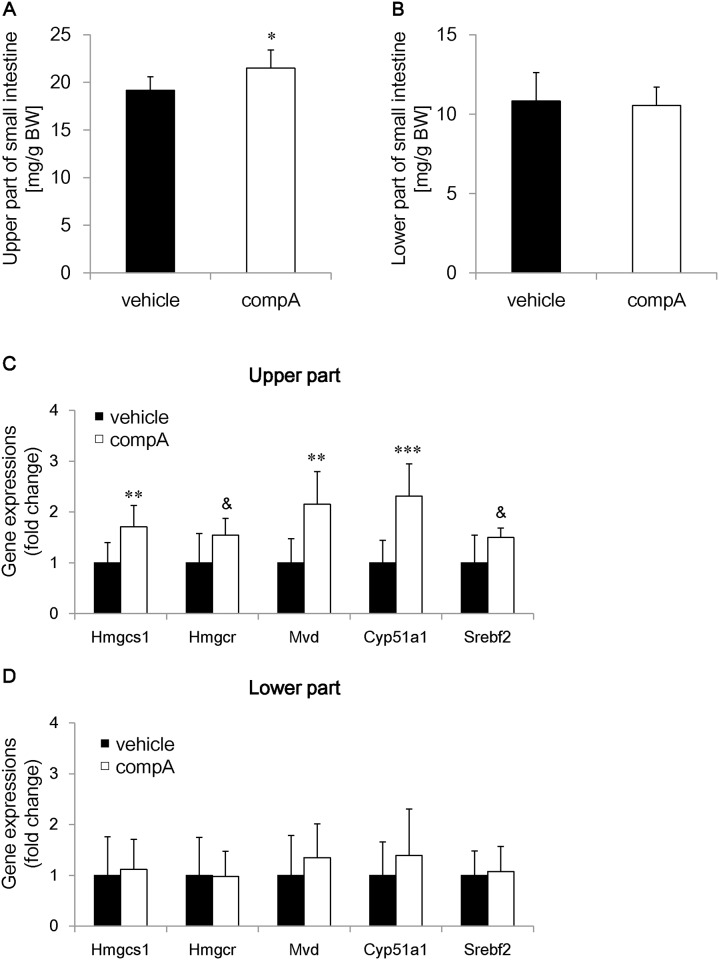
Intestinal remodeling by compA in high-fat diet-streptozotocin (HFD-STZ) mice.The small intestine of HFD-STZ mice was collected after 6-week administration of 30 mg/kg compA. Mean (A) tissue weight of the upper and (B) lower halves of the small intestine. Mean levels of gene expression for select enzymes involved in cholesterol metabolism in the (C) upper and (D) lower halves of the small intestine. n = 7 (for the weight of the upper intestine) or n = 8. *: P < 0.05, **: P < 0.01, ***: P < 0.001 vs. the vehicle-treated group by Student’s t-test. &: P < 0.05 vs. the vehicle-treated group by Aspin–Welch test.